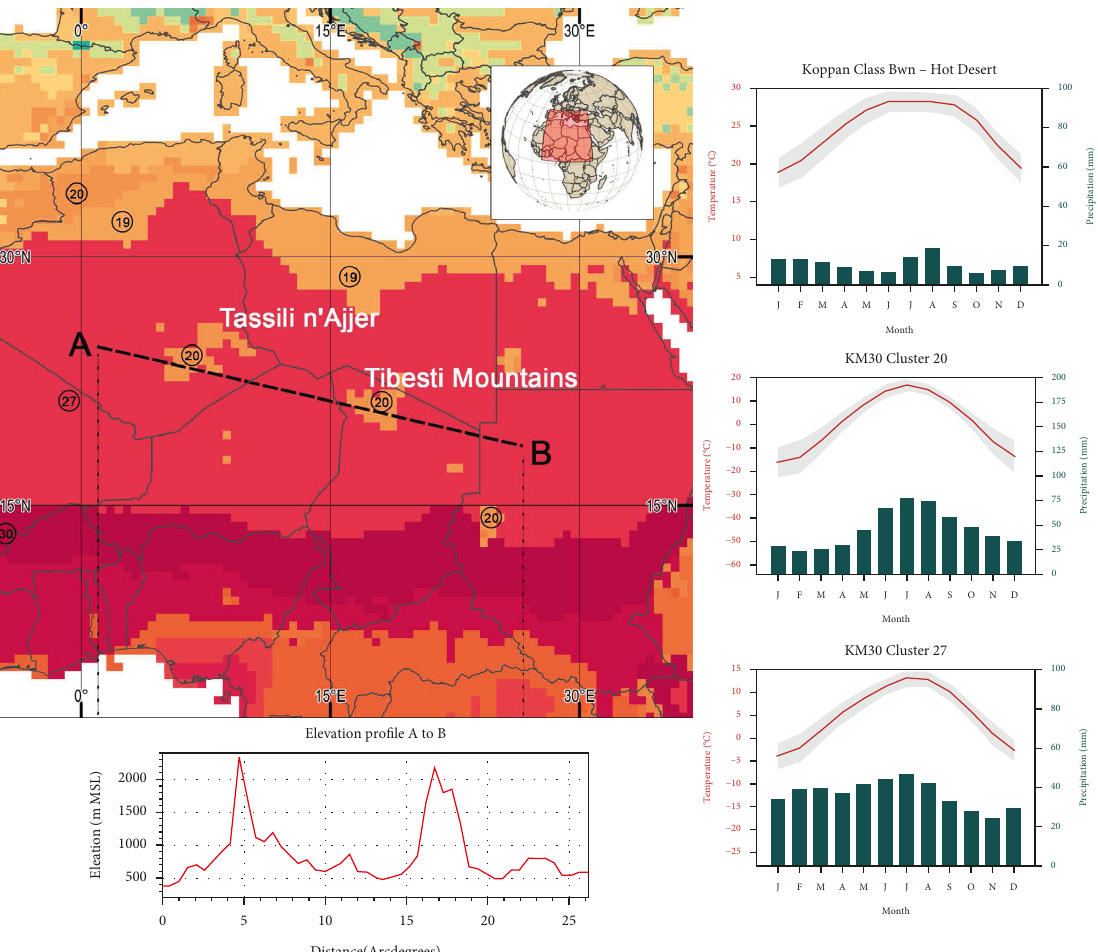
Figure 16: Left: Tibesti and Tassili n’Ajjer mountain regions in the Sahara. Right: Climographs of Bwh—hot desert K¨oppen climate and clusters 20 and 27 of KM30 classification. Bottom: elevation profile from A to B showing higher elevation regions within the